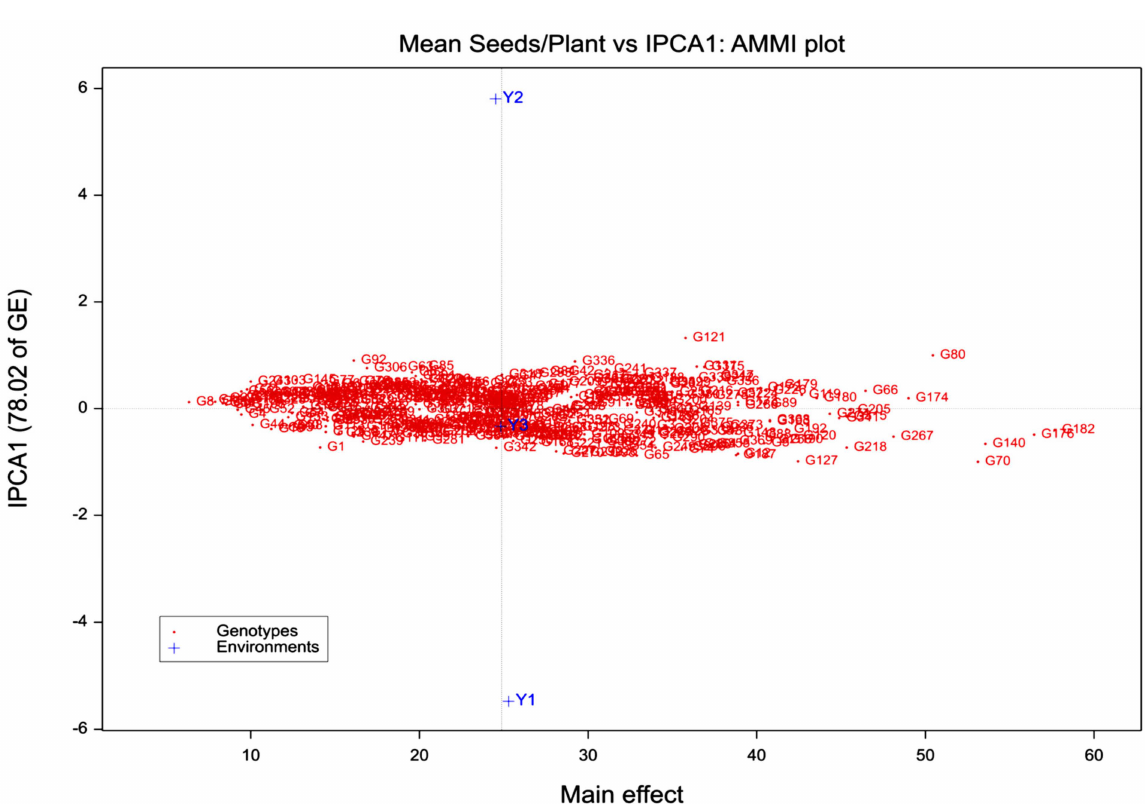
Figure 2. AMMI1 biplot for seed number. G59 had the highest mean seed weight (49.1 g) with good stability (IPC1 score of − 0.28). G60 and G61 had high mean seed weights (48.7 and 48.7, respectively) and IPC1 scores nearing zero ( − 0.09 and − 0.25, respectively). The most unstable genotype identified was G182 (IPC1 score of − 0.78), with a mean seed weight of 24.8